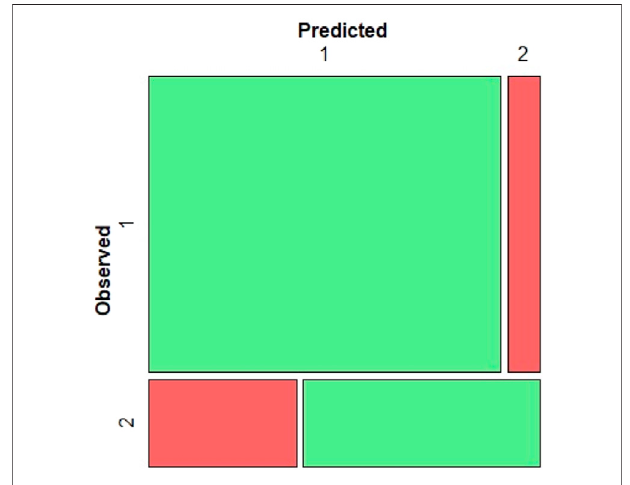
FIGURE 2 | Graph of the confusion variable (threshold a